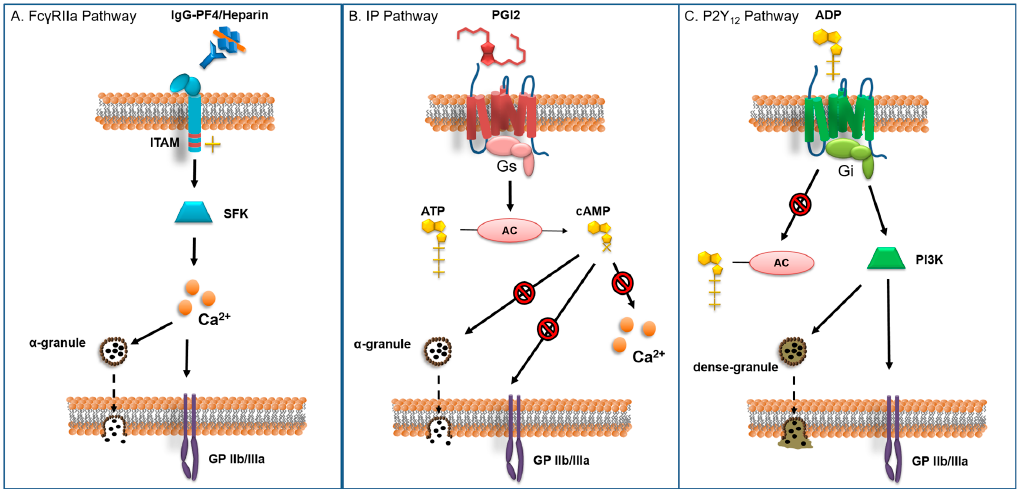
Figure 1. Platelet activation pathways: ( A ) Fc γ RIIa receptor pathway: The Fc segment of the IgG- PF4/Heparin complex binds to the extracellular segment of the Fc γ RIIa receptor. This leads to phosphorylation of the intracellular ITAM segment and the activation of intracellular signaling cascades through several SFKs. These trigger the liberation of intracellular Ca 2+ stores, which in turn